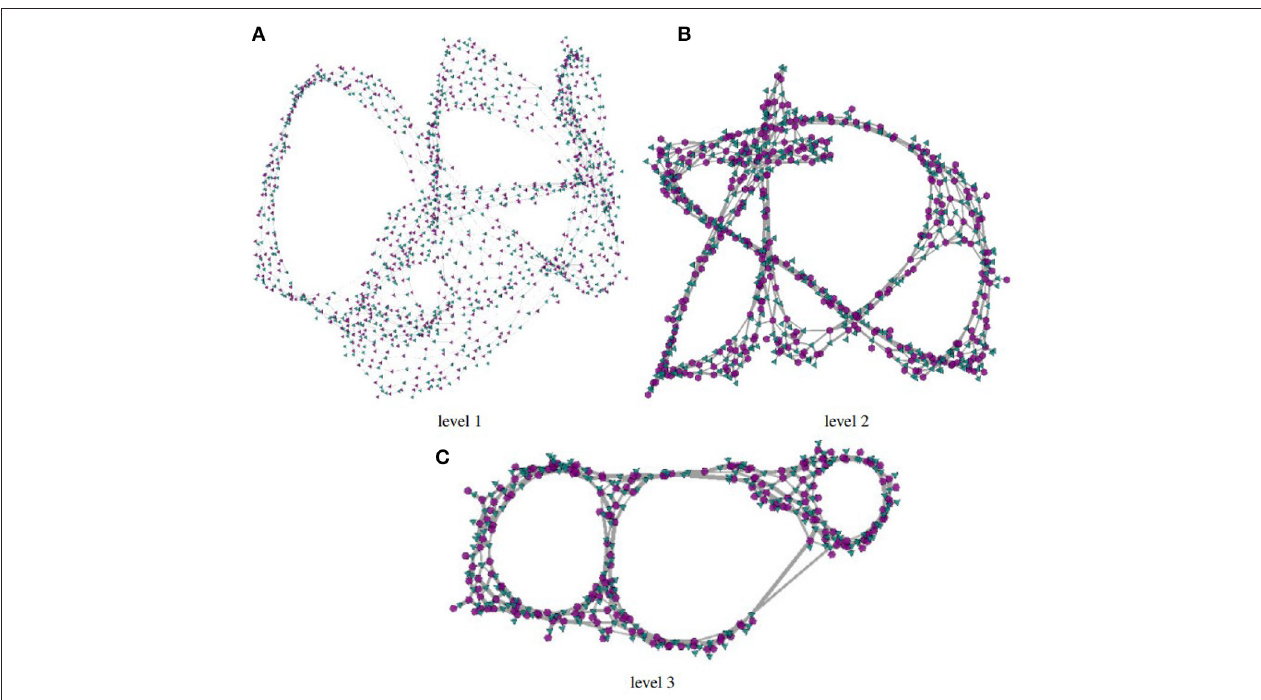
FIGURE 5 | Node link layouts of the “HB/jagmesh7” network obtained in BiNetViz, at three increasing levels of coarsening: in (A) the network has | V 1 | = 623 and | V 2 | = 626 nodes and 2,291 links; in (B) it has | V 1 | = 342 and | V 2 | = 357 nodes and 1,289 links; whereas, in (C) it has | V 1 | = 194 and | V 2 | = 199 nodes and 699 links. Node-link layouts have been obtained with the Fruchterman-Reingold algorithm, and the coarsening hierarchy has been computed with the GMb